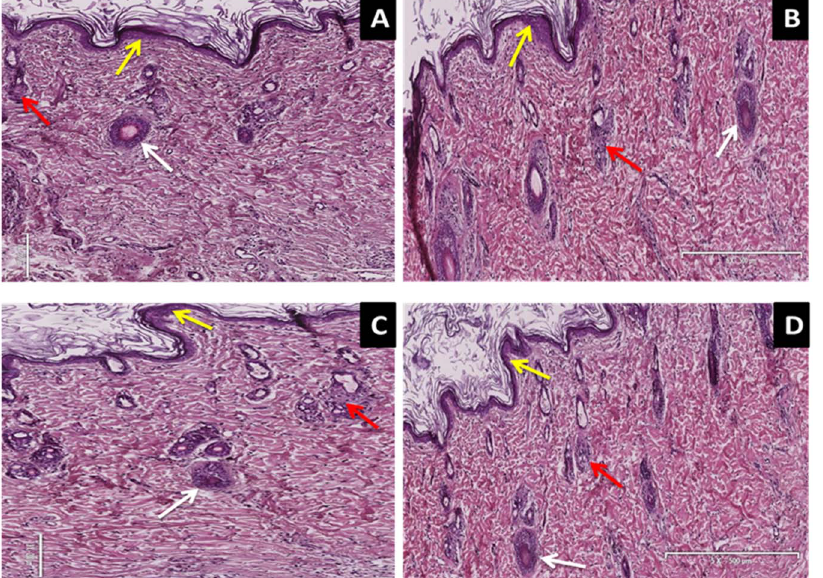
Figure 1. H & E stains illustrating the effects of insulin-containing dermal patches on the morphology of the skin in STZ-induced diabetic rats. Picture A represents intact secretory ducts (white arrow), stratum basale (yellow arrow) and intact sebaceous glands (red arrow) of the untreated control animals. (Mag 8 6 500 m m). Picture B represents intact secretory ducts (white arrow), uninjured stratum basale (yellow arrow) and intact sebaceous glands (red arrow) of the PI treated animals. (Mag 8 6 500 m m). Pictures C represents intact secretory ducts (white arrow), uninjured stratum basale (yellow arrow) and intact sebaceous glands (red arrow) of the subcutaneously insulin treated animals (Mag 12 6 500 m m).